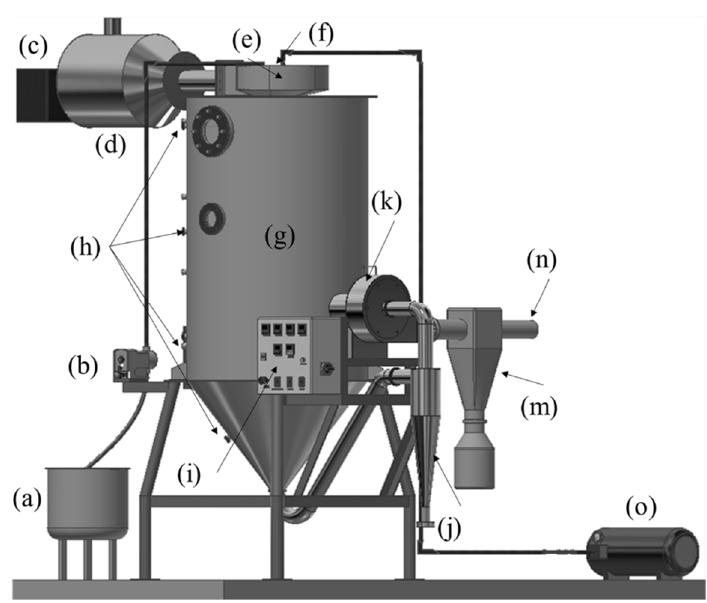
Figure A2. Schematic representation of the spray dryer used to produce the SiO 2 –Al 2 O 3 microspheres. ( a ) Feed tank, ( b ) peristaltic pump, ( c ) direct combustion burner, ( d ) combustion chamber, ( e ) gas disperser, ( f ) rotary atomizer, ( g ) drying chamber, ( h ) thermocouples, ( i ) control panel, ( j ) cyclone dust separator, ( k ) extractor, ( m ) bag filter, ( n ) spent gas outlet, and ( o ) air compressor. Four experiments were performed for each atomization disc design, varying the rotational speed of the discs in the range of 3000 to 14,000 rpm (Table